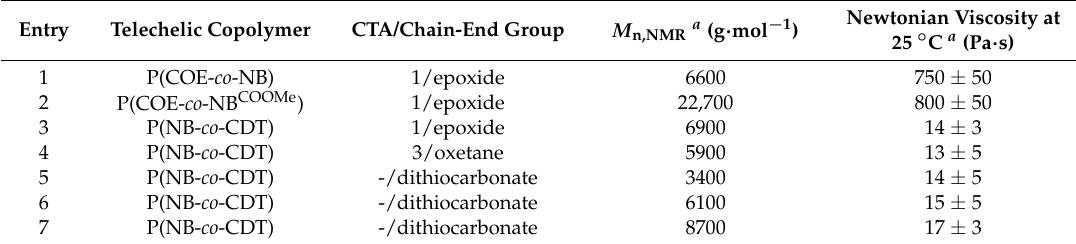
Table 6. Newtonian viscosity of telechelic P(NB- co -CDT)